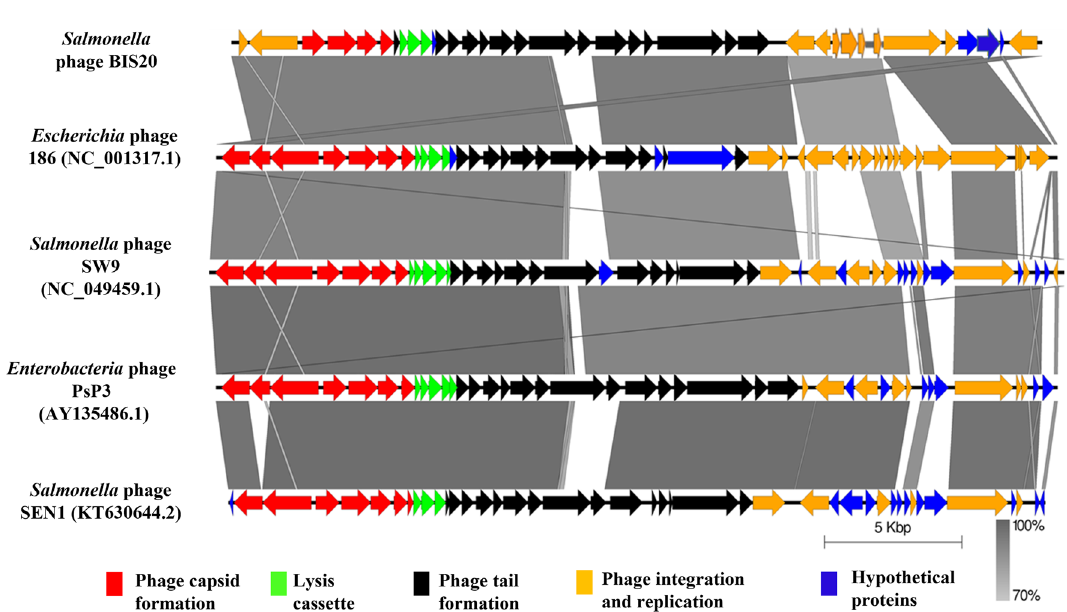
Figure 5. Genome comparison of BIS20 with closest bacteriophage homologs of genus Eganvirus . Various ORFs are color coded according to their putative function. (Scheme provided in Fig.